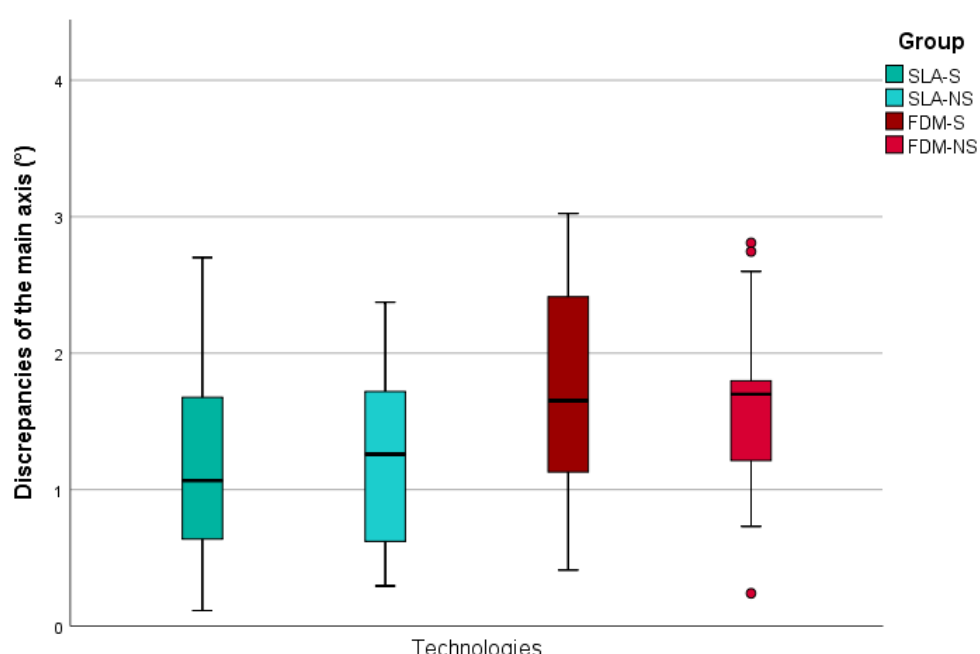
Figure 4. Boxplots of minimum, maximum, interquartile range, median, and outliers for discrepancies of the implant main axis. SLA: stereolithography, FDM: fused deposition modeling, S: metal sleeve, NS: no metal sleeve, x: sagittal discrepancies, y: transversal discrepancies, z: vertical